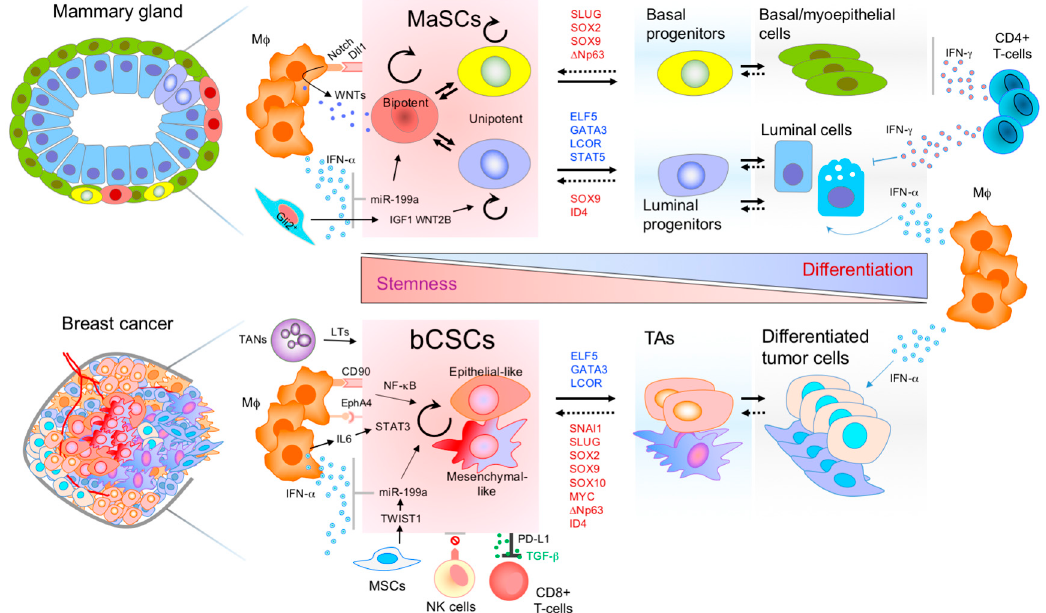
Figure 1. Molecular networks and immune regulation of mammary stem cells (MaSCs) and breast cancer stem cells (bCSCs). Similar immune cell components form the stem cell niche and the microenvironment of both stem cell phenotypes, normal and malignant. Transcription factors (TFs) inducing stem cell properties in the normal mammary gland (red letters), also induce stemness in breast cancer cells and increase tumor aggressiveness. On the other hand, luminal differentiation TFs of the mammary gland (blue letters), also induce differentiation in breast cancer cells and tumor suppression. Breast CSCs can be epithelial-like CSC or mesenchymal-like CSCs. The hierarchical organization of both tissues is highly dynamic, and the stem cell pool can be replenished from non-stem cell populations. Therefore, transitions can be bidirectional demonstrating cellular plasticity and environmental regulation of the mammary epithelial cells. M ϕ , macrophage; TANs, tumor associated neutrophils; MSCs, mesenchymal stem cells; NK, natural killer; TAs, transit amplifying cells; LTs,